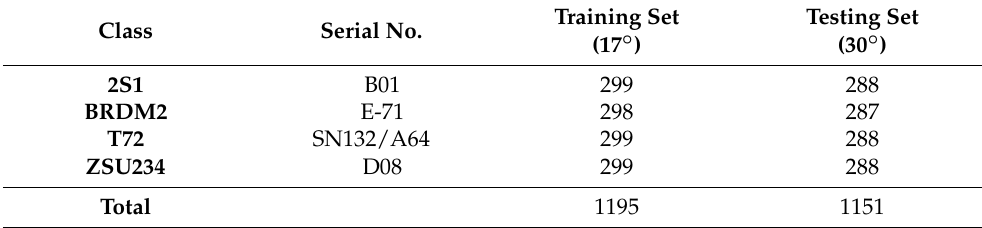
Table 7. Data description for EOC.